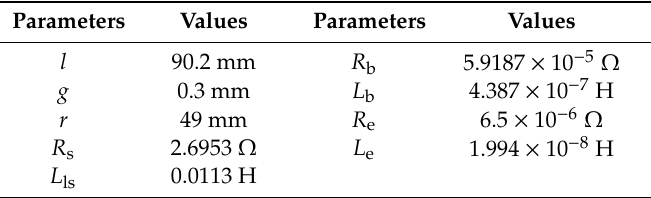
Table 2. Motor parameters.